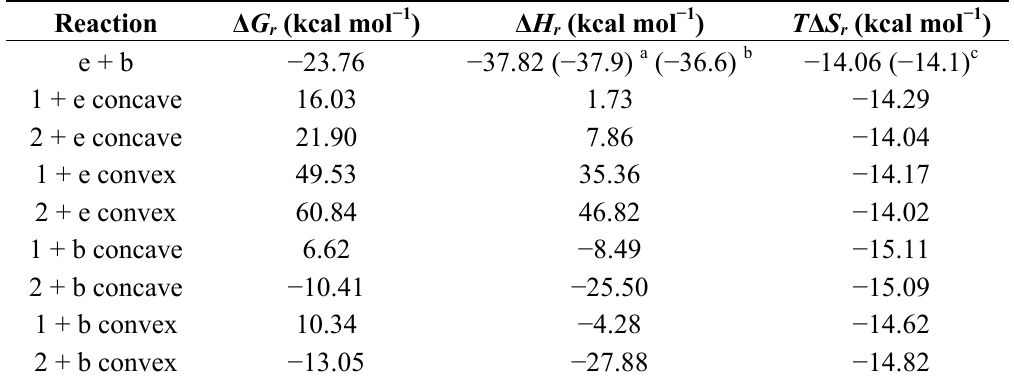
, standard enthalpies Δ H r